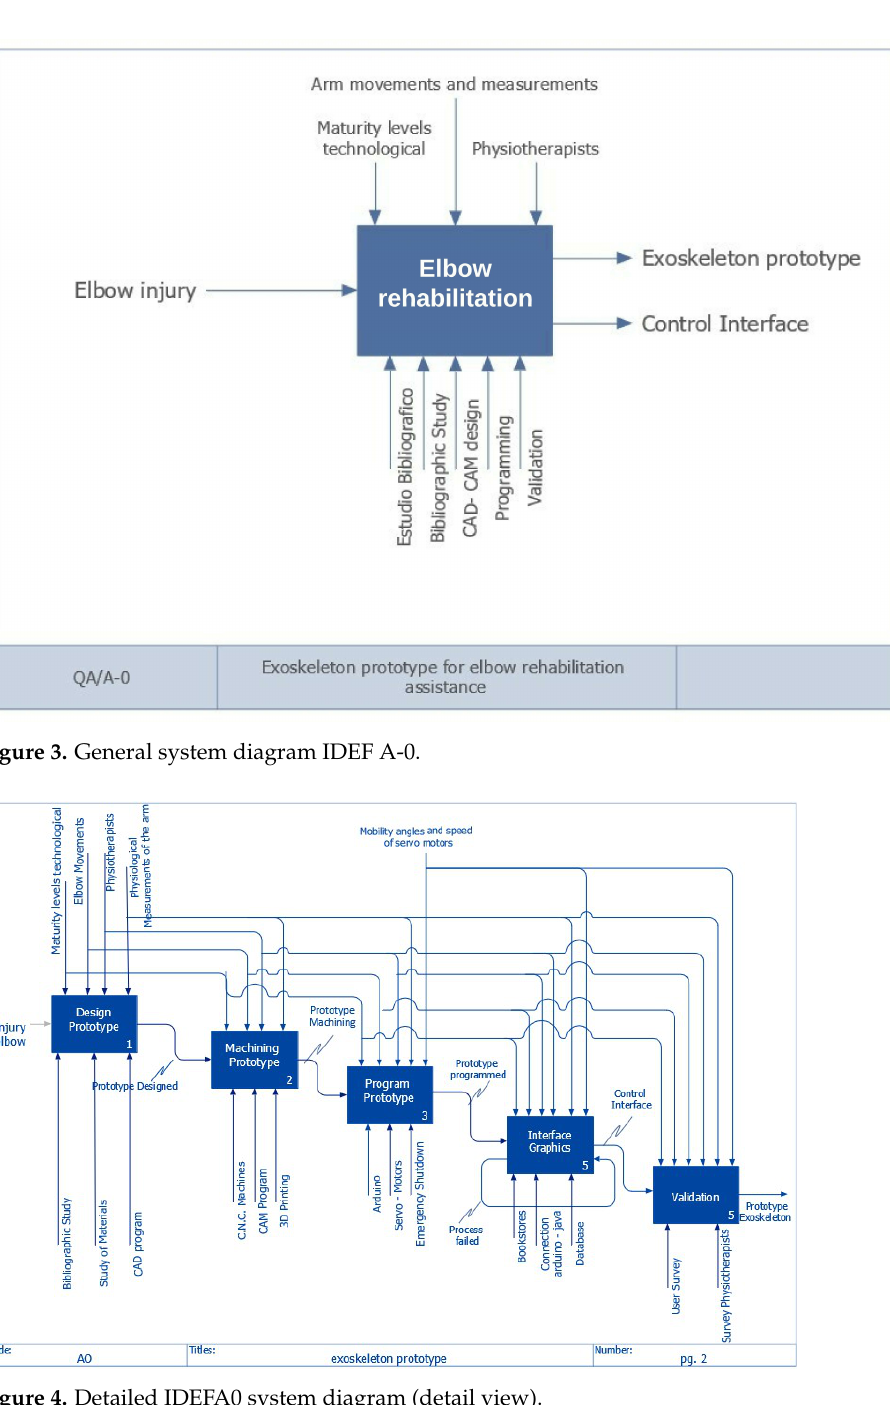
Figure 4. Detailed IDEFA0 system diagram (detail